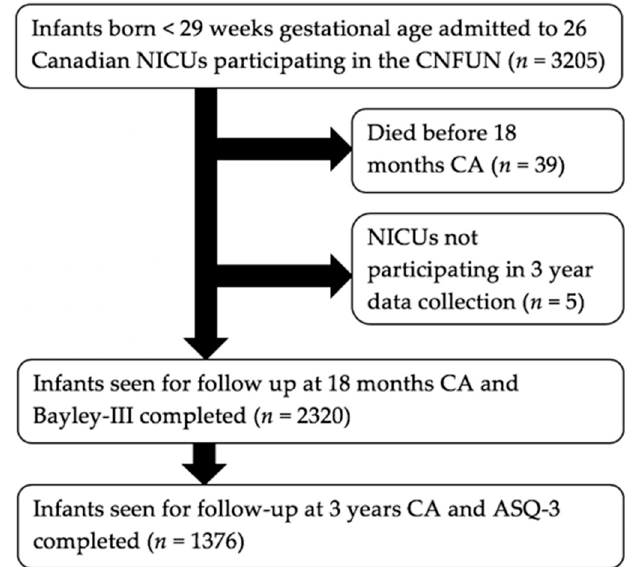
Figure 1. Flow chart depicting study participant data.